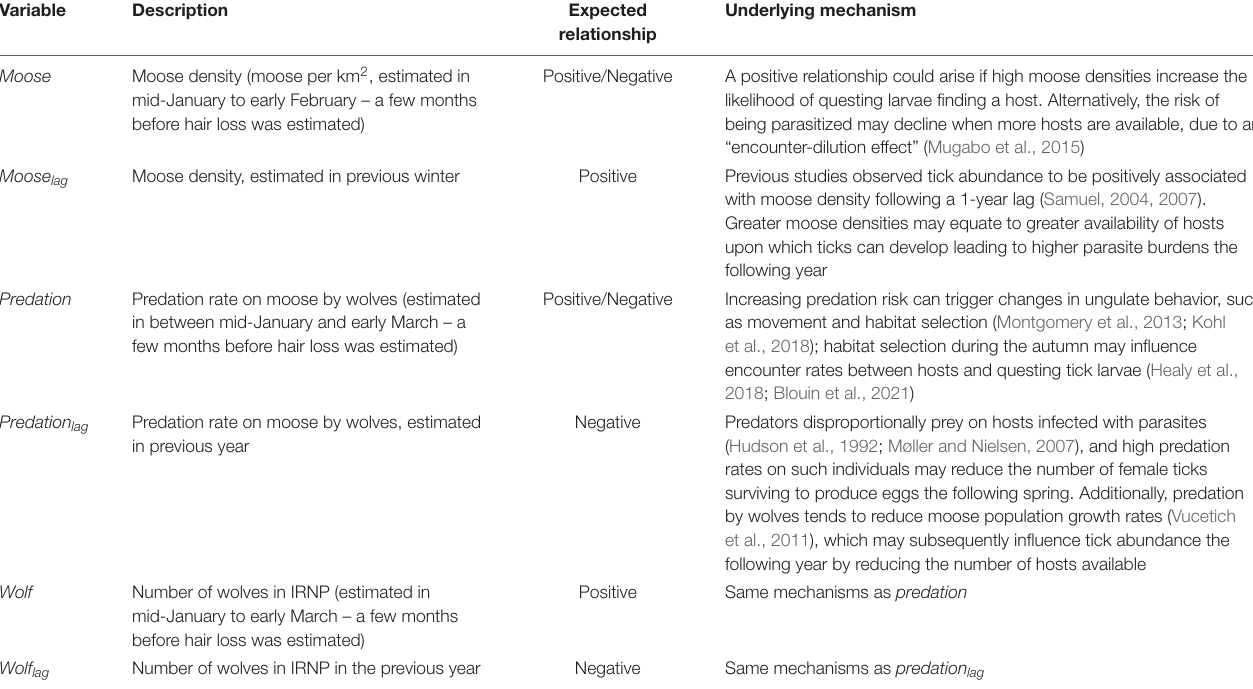
TABLE 1 | Hypotheses pertaining to the influence of non-climatic factors on tick burdens for moose as indicated by the extent of hair loss (see Figure 1 ).